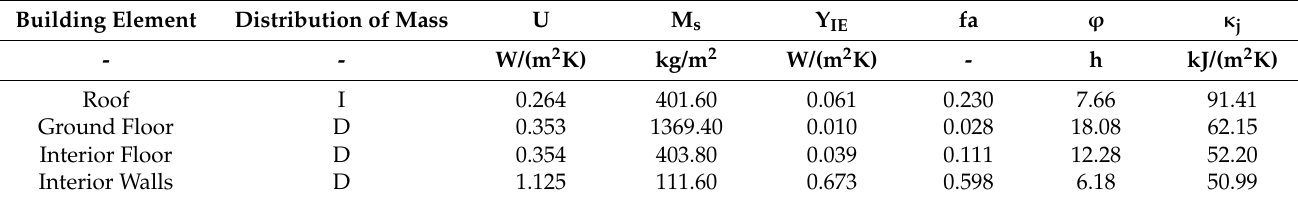
Table 3. Thermo-physical characteristics of fixed structures. I: mass concentrated on the internal side. D: distributed mass.